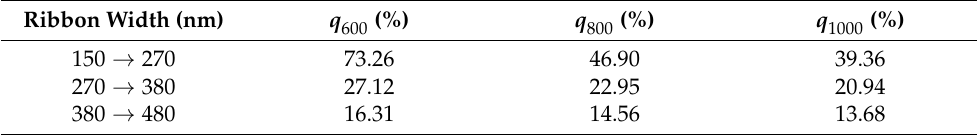
Figure 8. Maximum of the plasmon peak ( ≤ 7 THz) at q = 600 cm − 1 and ν = 4.0 × 10 13 s − 1 . Table 7. Percentage variation in plasmon frequency by increasing ribbon width for selected momenta and at ν = 4.0 × 10 13 s − 1